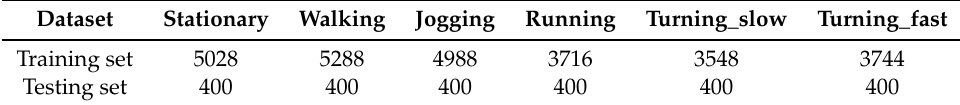
Figure 6. Circuit diagrams for collecting samples of ( a ) linear movements and ( b ) turning movements. Table 4. Summary of acquired samples for training the proposed DCNN.